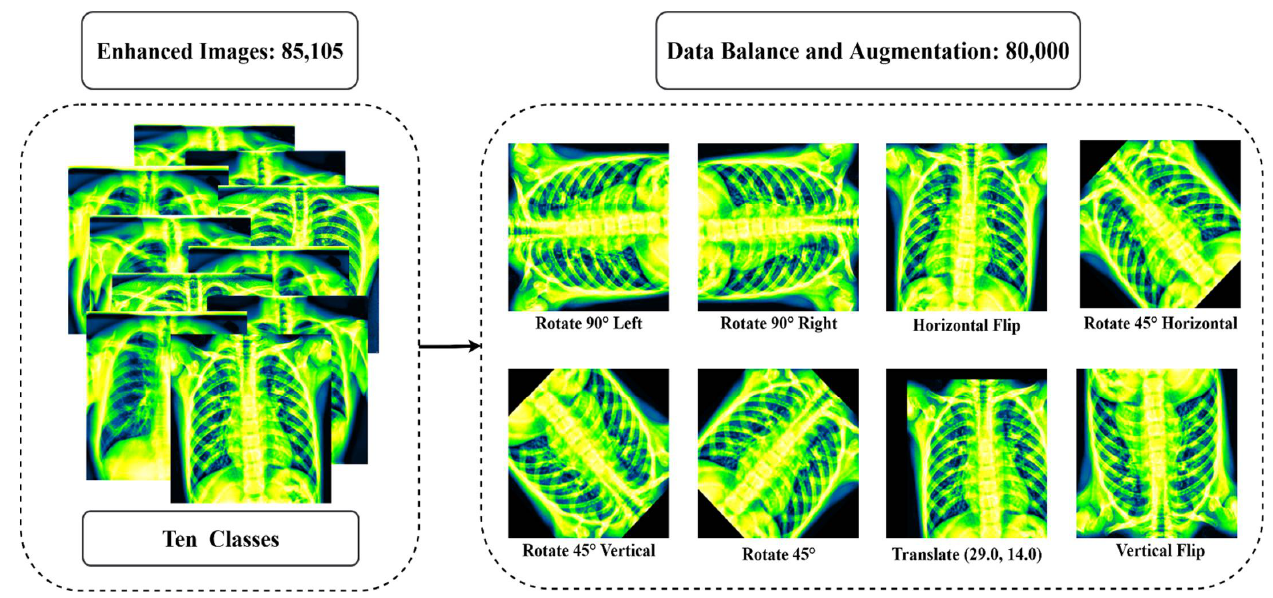
Figure 8. The outcome after balancing all class and using eight augmentation procedures: Rotate 90° left, Rotate 90° right, Horizontal flip, Rotate 45° Horizontal, Rotate 45° Vertical, Rotate 45°, Translate, Vertical flip. Table 5. The final dataset after